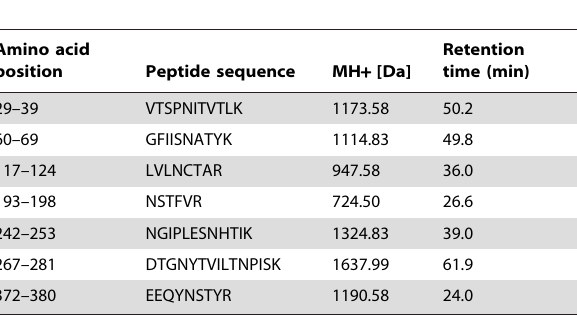
Table 1. All seven N-glycosylated tryptic peptides identified with treatment of PNGase